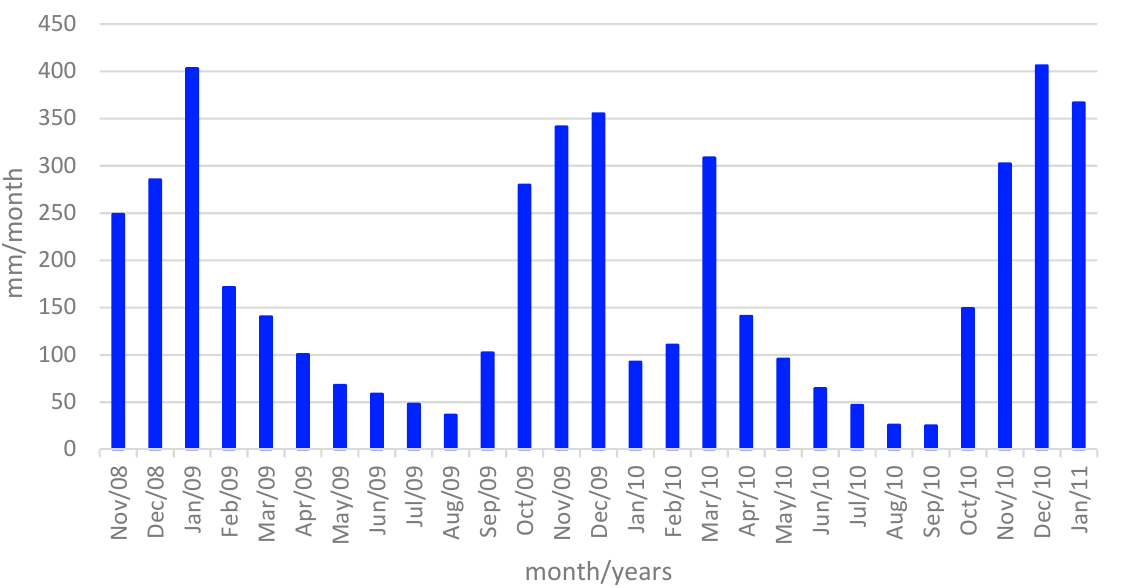
Figure 2. Total accumulated monthly precipitation for the period between 2008 and 2011 in the study area. The data from January 2011 represent the accumulated precipitation up to the 15th of this month, due to the destruction of stations in the event.